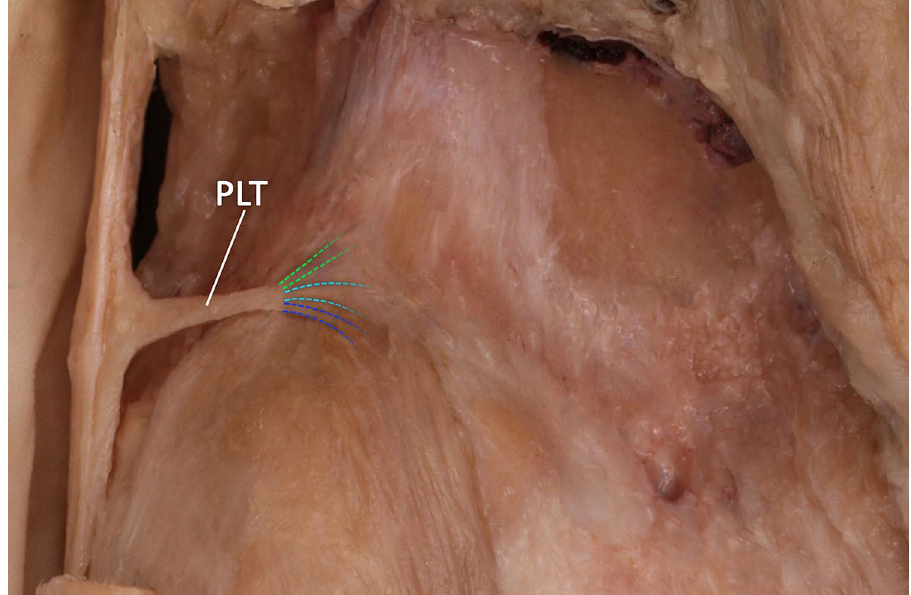
Figure 2. Proximal attachment of the plantaris ligamentous tendon. PLT plantaris ligamentous tendon. Dotted green lines show attachment to posterior surface of the femur. Dotted turquoise lines show attachment to the capsule of the knee joint, while dotted blue lines show attachment to the plantaris muscle.